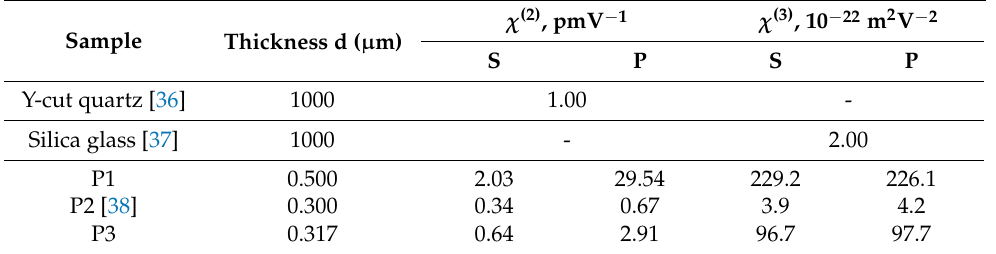
Table 2. Second- and third-order NLO susceptibilities ( χ (2) , χ (3) ) of P1 , P2 and P3 polymers.